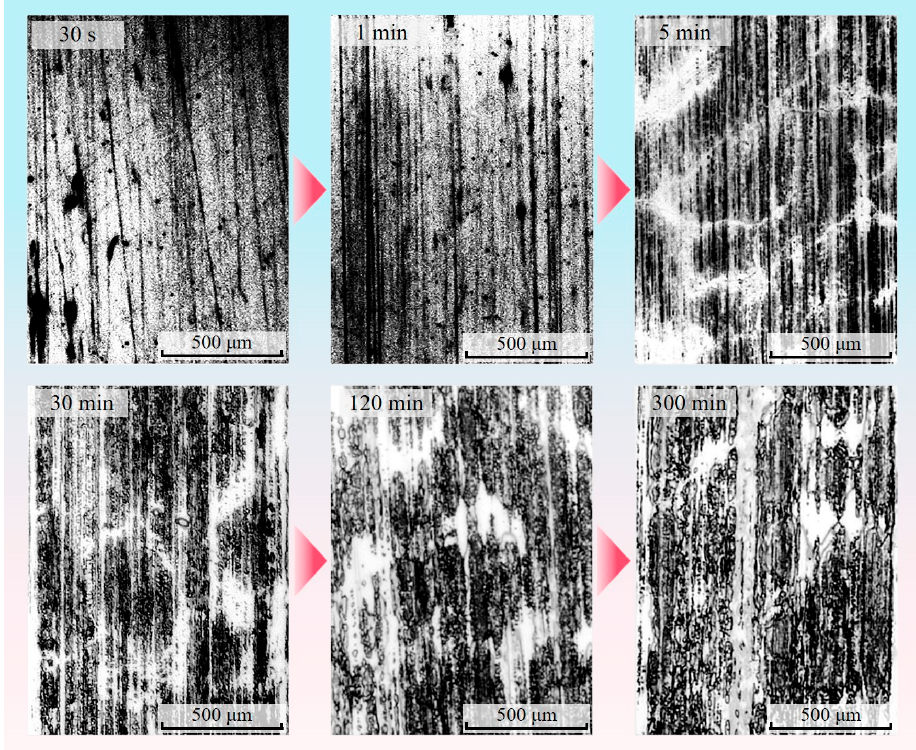
Figure 6. Transfer film image after median filtering and edge sharpening.